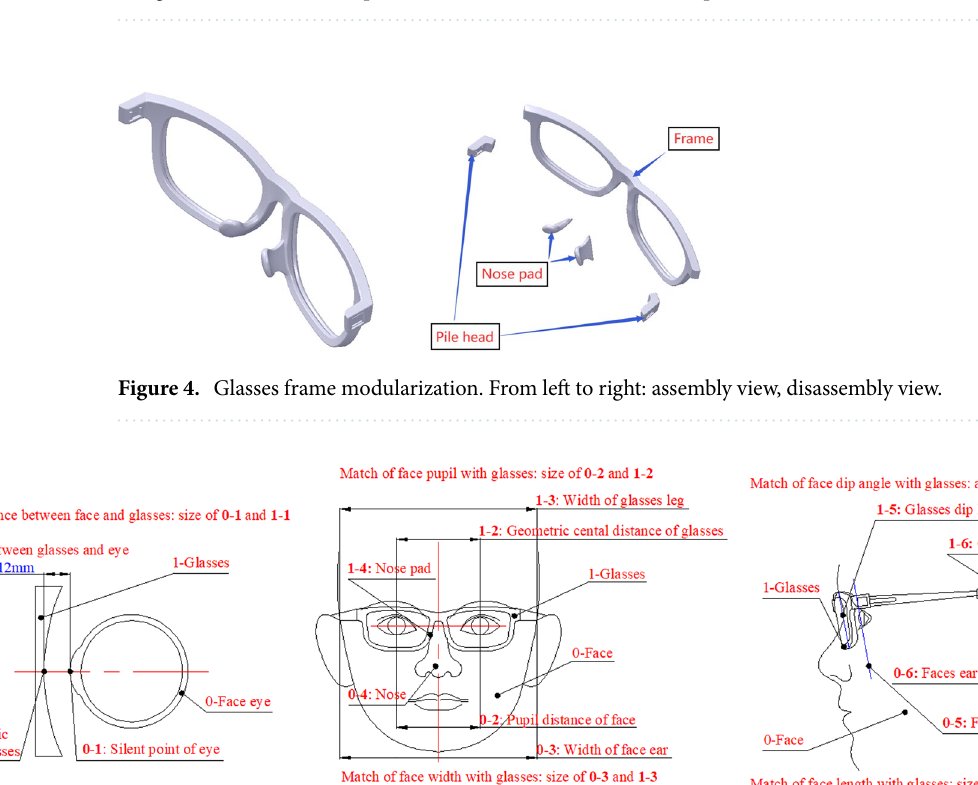
Figure 3. The connection relationship problems at the deformation position marked with red ellipse. From left to right: deformation at the pile head and deformation at the nose pad.